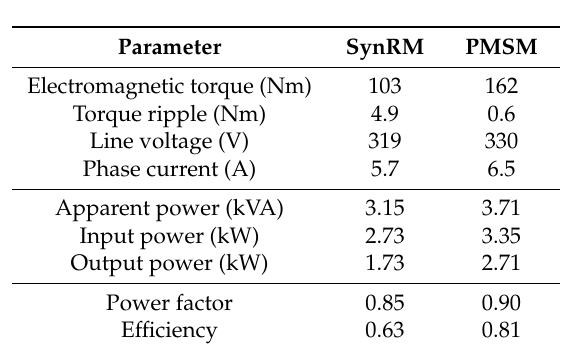
Table 8. SynRM and PMSM characteristics for the same torque requirement.